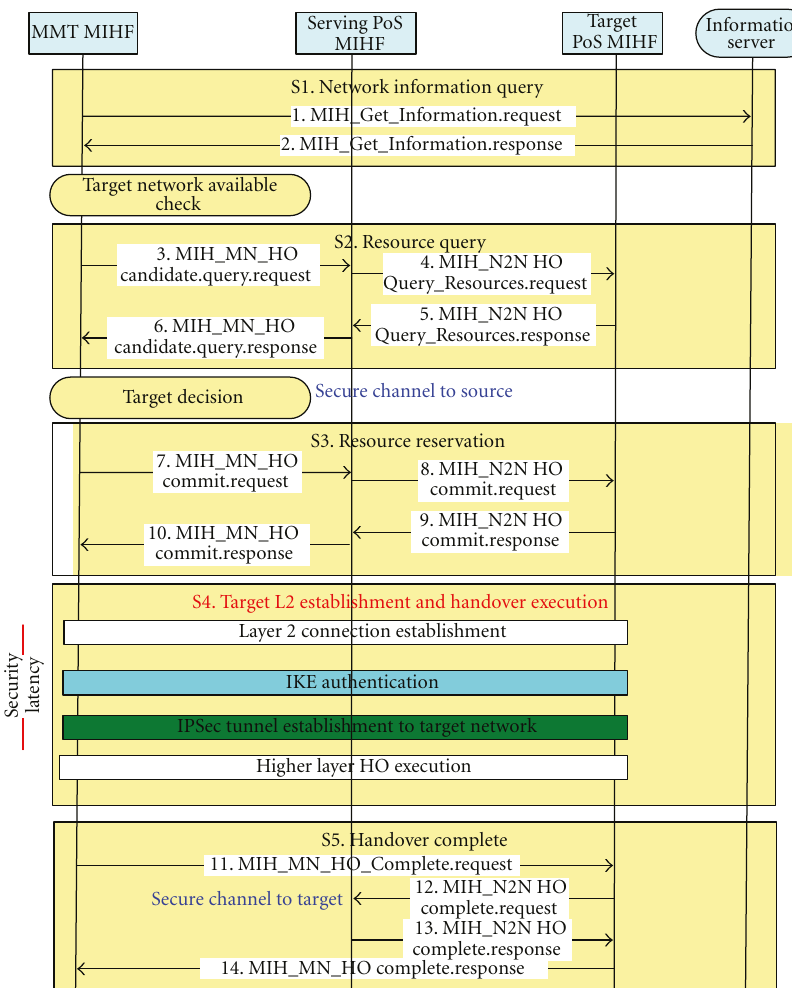
Figure 9: Securing MIH with